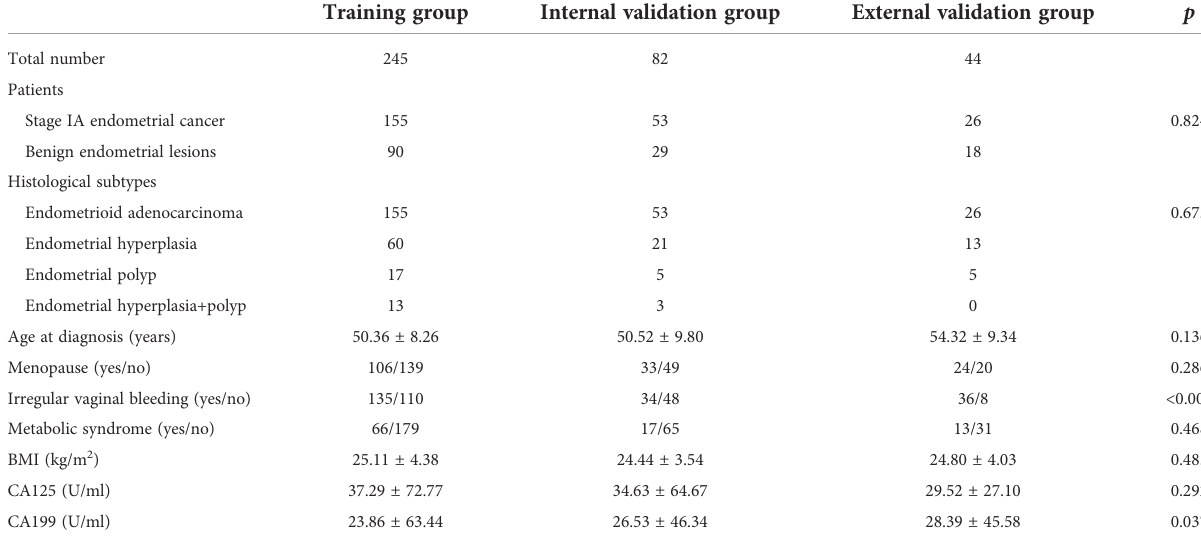
TABLE 2 Clinical and histological characteristics for